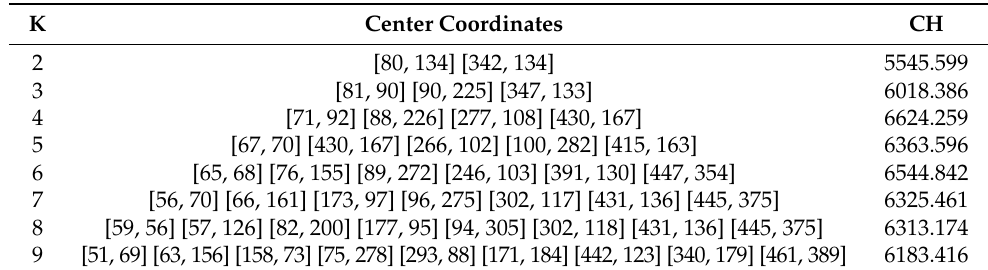
Table 1. Clustering results under different cluster